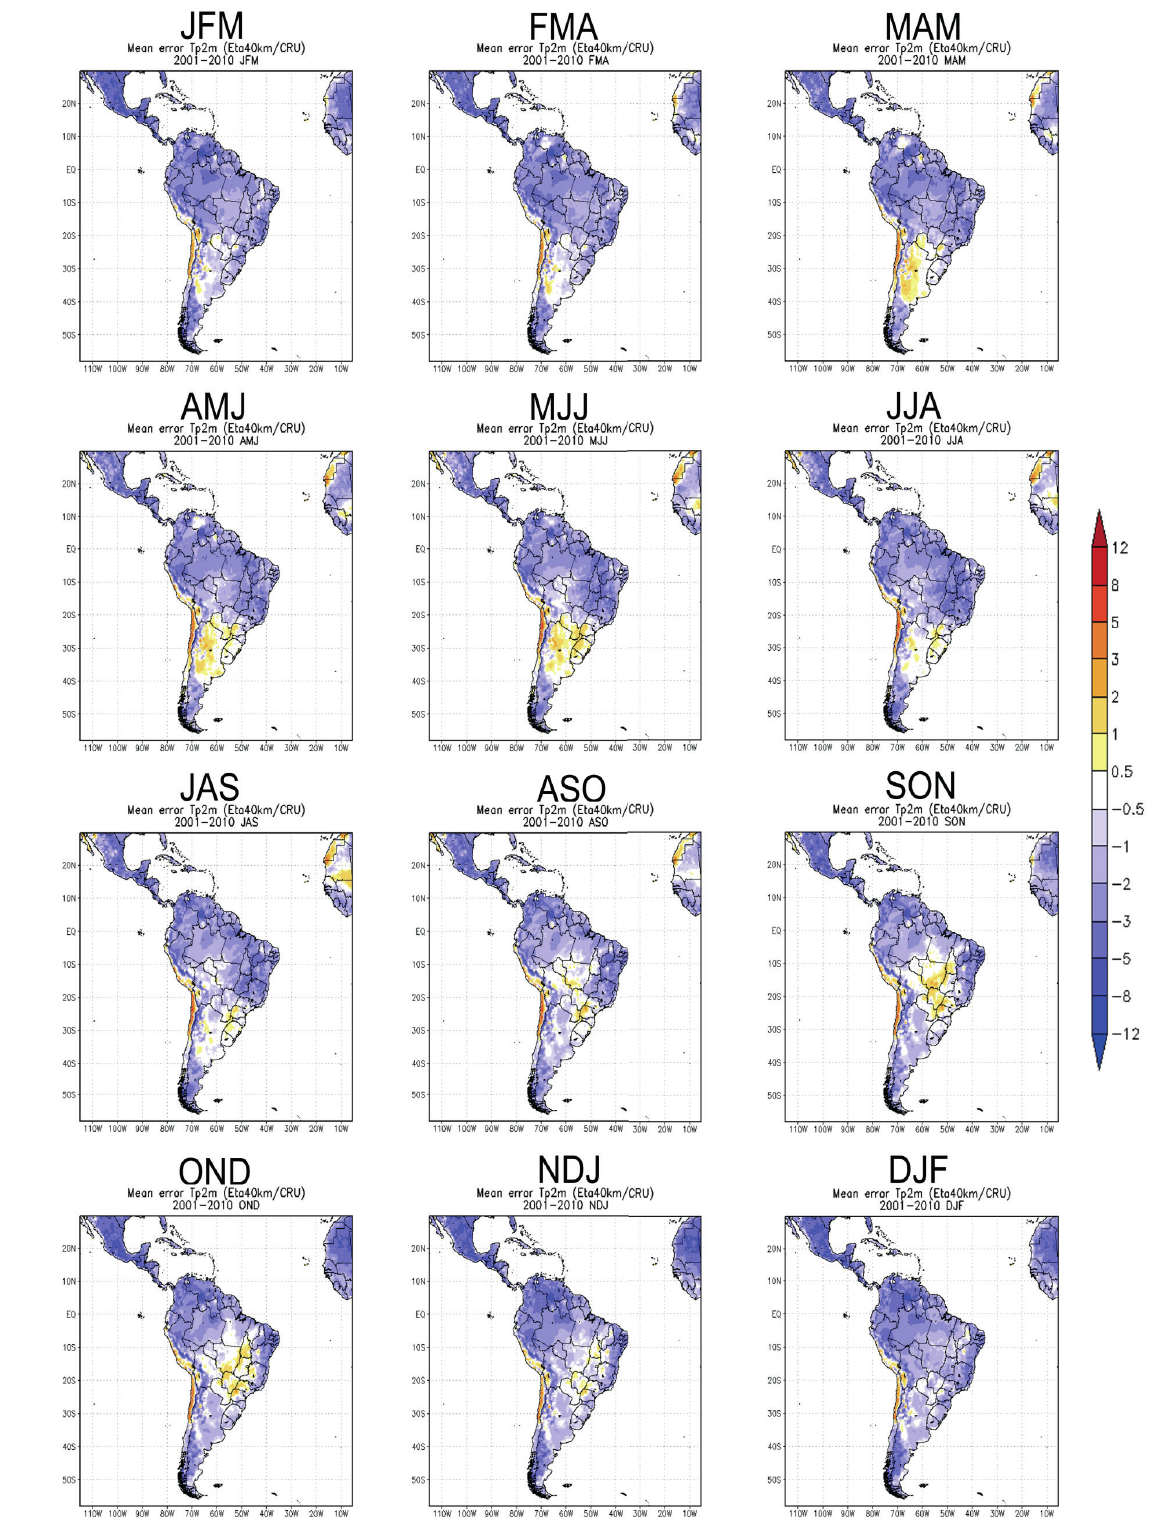
Figure 5. Seasonal 2-meter temperature errors ( o C), average from 2001-2010 and fi ve ensemble